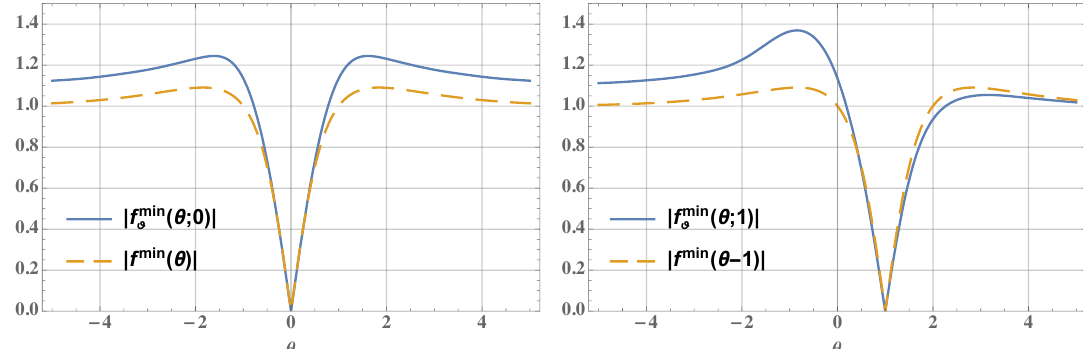
Figure 10. We plot the minimal two particle form factor over the background (of temperature (cid:12) = 1) and over the vacuum. Both plots are again for the Sinh-Gordon model with interaction parameter B = 1 =